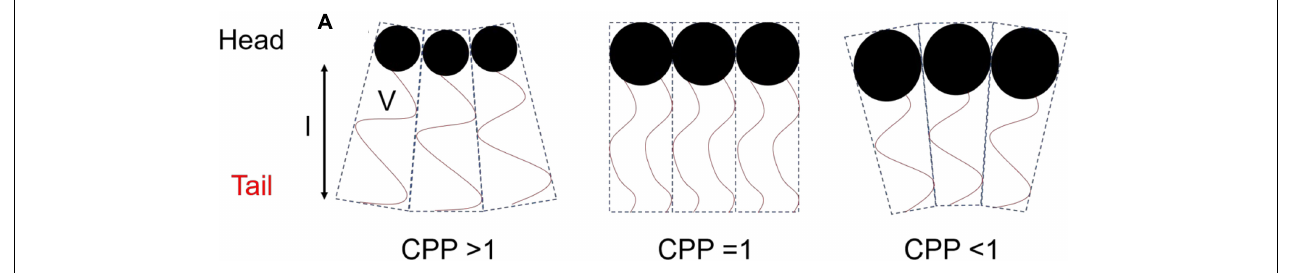
FIGURE 2 | Schematic diagram of the geometry of packing of amphiphilic molecules and corresponding CPP values. This image was based on and redrawn from Du et al.